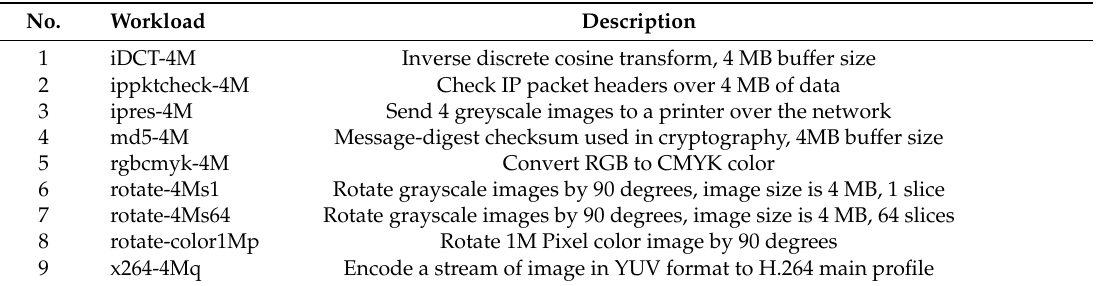
Table 5. EEMBC parallel-mode workloads.